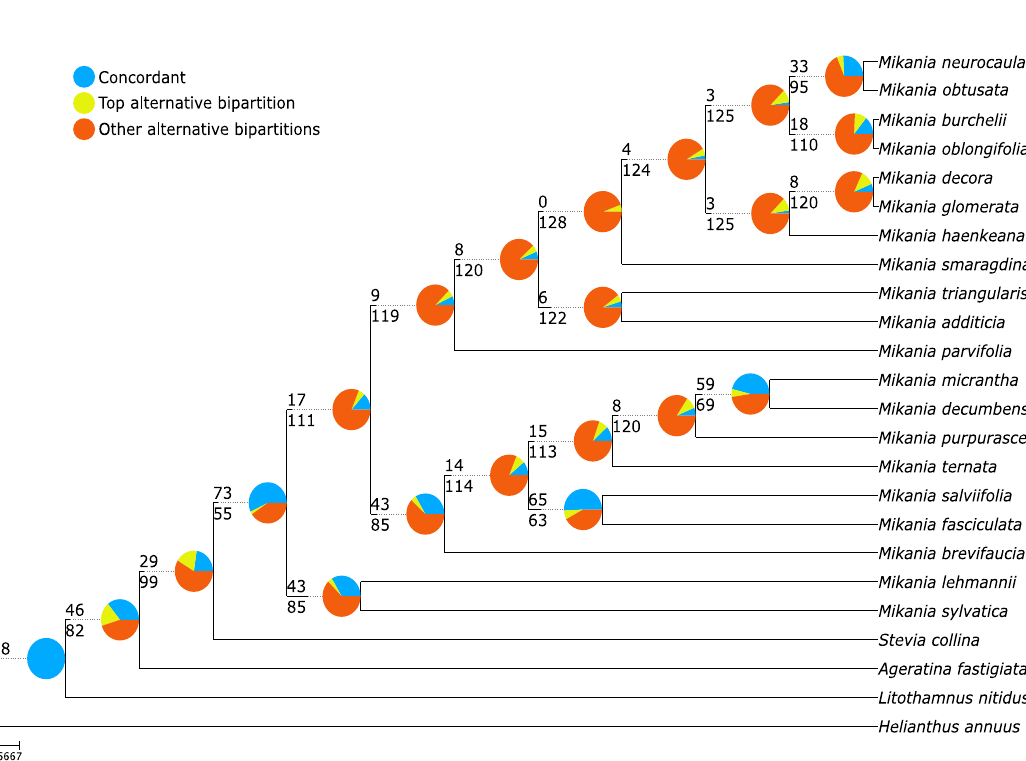
Figure 5. Gene tree discordance analysis conducted with the total dataset and multispecies coalescent inference (Astral total). The number above the branch indicates the number of concordant gene trees and the one below the number of conflicting gene trees. Pie charts indicate the proportion of gene trees supporting that clade (blue), the proportion that supports the main alternative topology for that clade (yellow), and the proportion that supports all other topologies